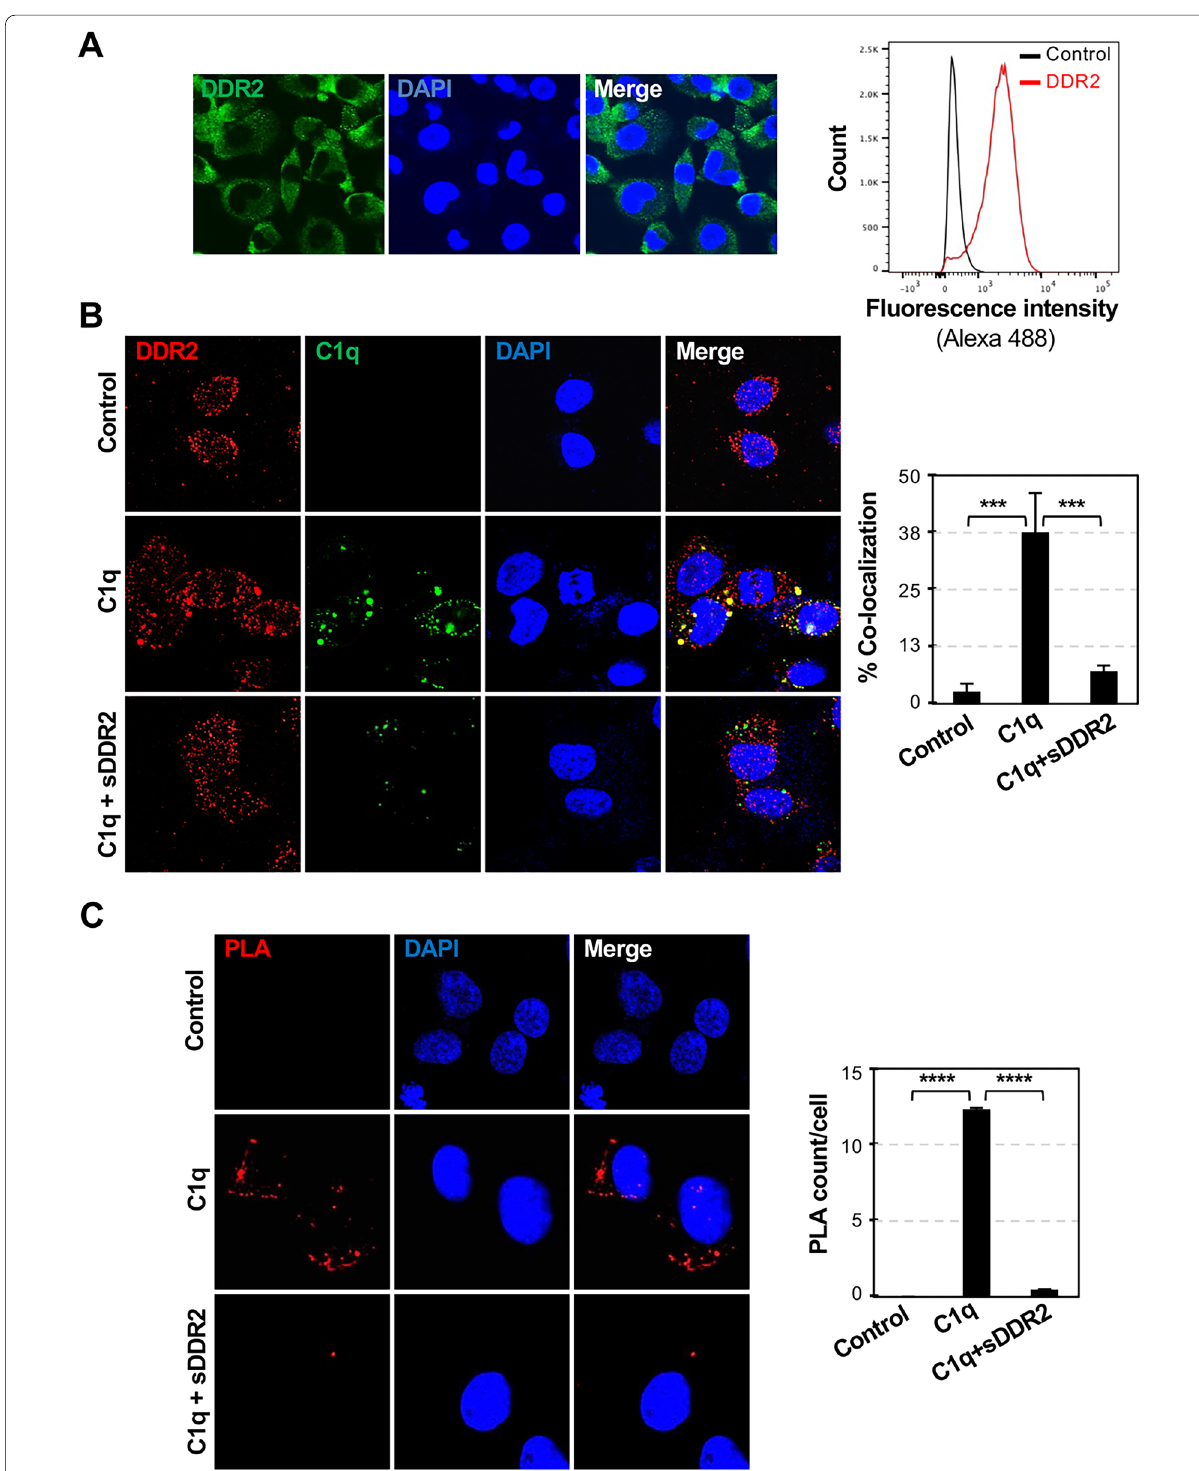
Fig. 2 Co‑localization of C1q to DDR2‑expressing cells. A DDR2 expression in the HT1080 cell line was determined using confocal microscopic images and flow cytometric analyses. B Confocal microscopy analysis showing co‑localization of C1q with DDR2 in HT1080 cells. The cells were treated with 2 μg/mL C1q in the absence or presence of 2 μg/mL sDDR2. Confocal images of the cells show dual staining for DDR2 (red) and C1q (green). The phenomenon was attenuated with the addition of sDDR2. C Proximity ligation assay (PLA) of DDR2 and C1q. The graph shows the mean SEM of three independent experiments. *** p < 0.001, **** p < 0.0001 (one‑way ±